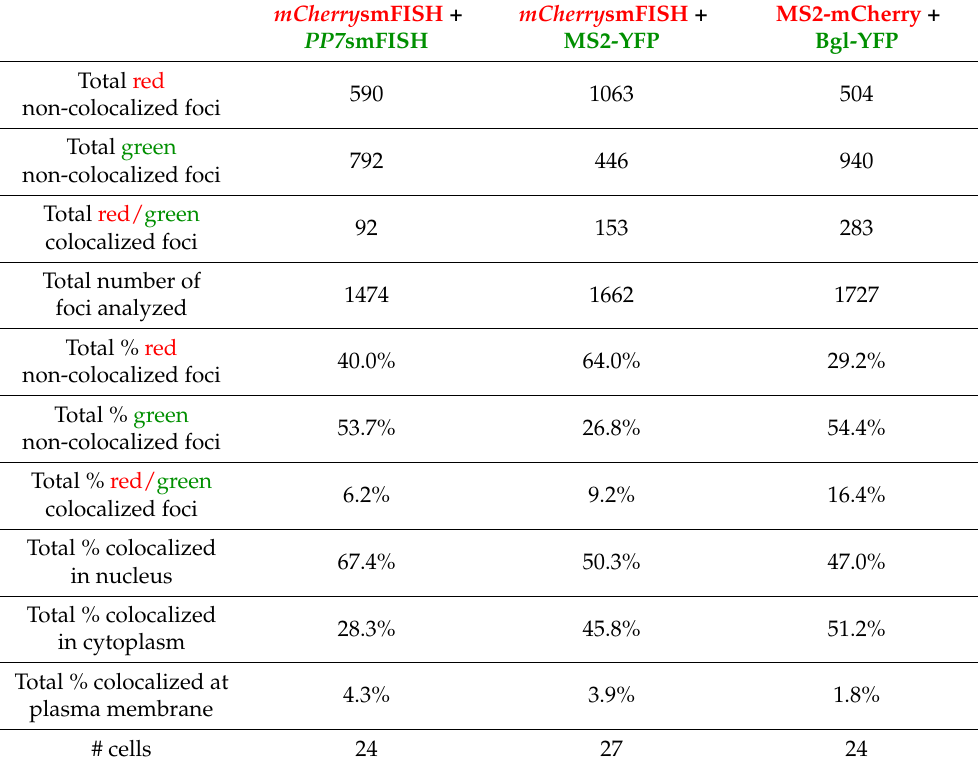
Table 1. Quantitation analysis of subcellular localization of genome heterodimers using three imaging combinations. The total number of non-colocalized red genomic RNA foci, non-colocalized green genomic RNA foci, and colocalized red/green genomic RNA foci per cell are shown. The percent of total heterodimers was calculated assuming that singly-colored unspliced vRNA foci present in the cell were genomic RNA homodimers. Genomic RNA foci were identified using the Imaris Spots function with a manually defined intensity threshold. Genomic RNA heterodimers were then quantified using the Imaris “Find colocalized spots” function with a threshold of 0.5 µ m, as described in Materials and Methods. To assess the subcellular location of genomic RNA heterodimers within subcellular compartments, DAPI staining was used as a mask to distinguish the confines of the nucleus and WGA staining was used as a mask to identify the plasma